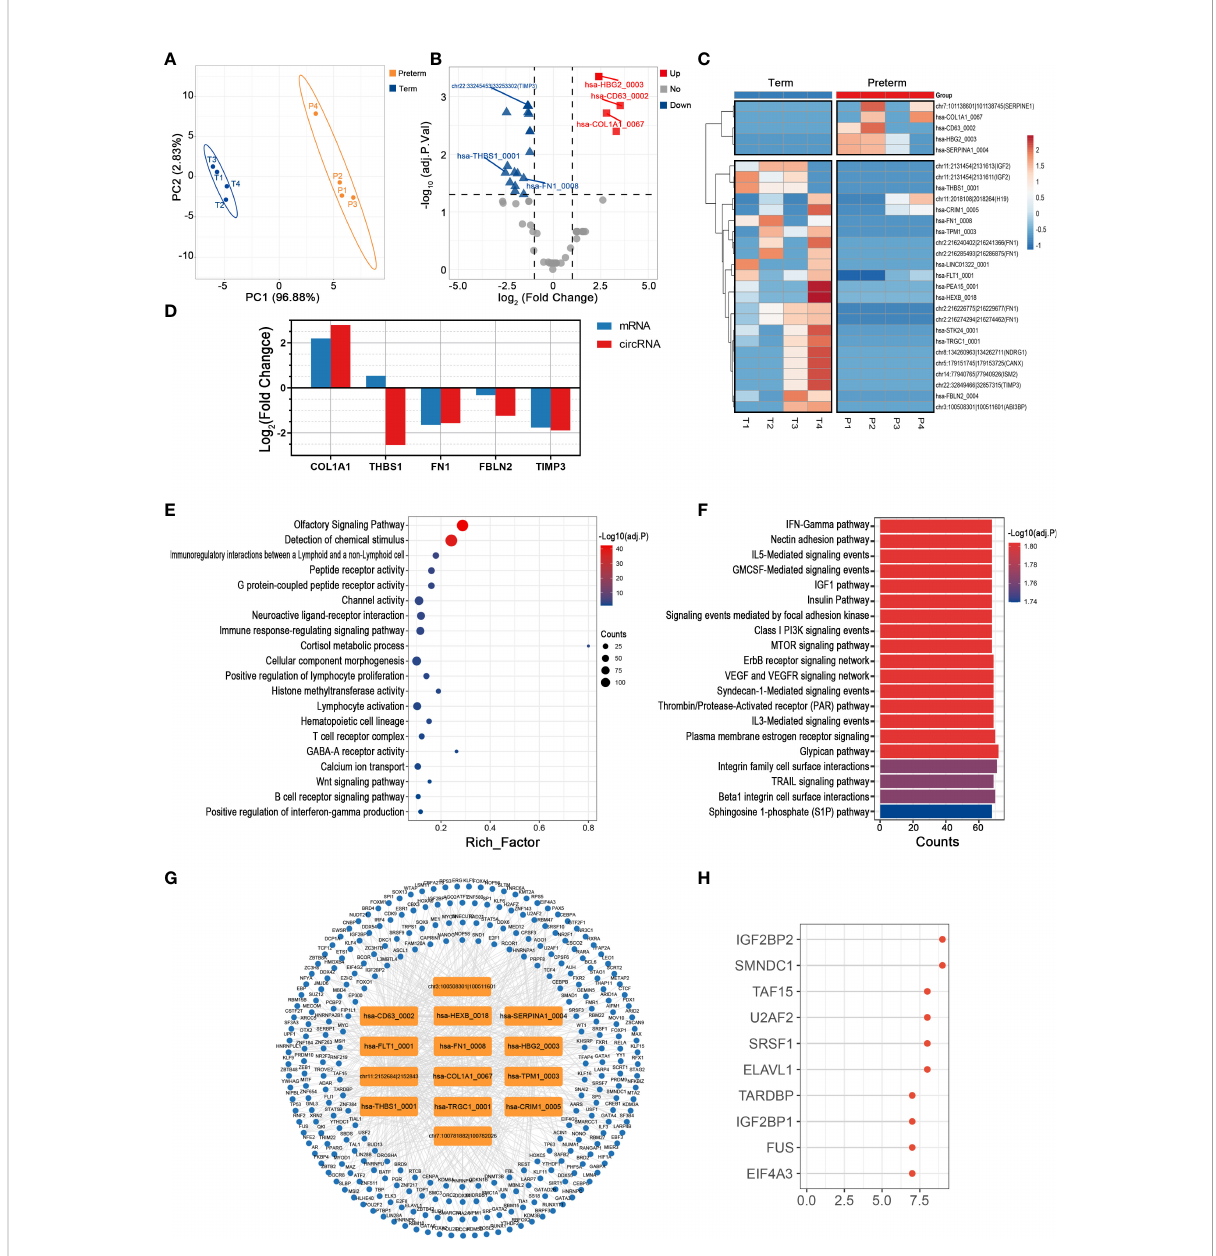
FIGURE 5 The circRNA changes and functional analyses in the chorion of PTB. (A) PLS-DA of circRNAs expression in preterm (yellow points) and term (blue points) chorion. (B) The volcano plot of circRNA changes and adj. p-values in the chorion of PTB. (C) The hierarchical clustering of DECs expression in term and preterm myometrium. (DECs: |log2 (fold change)|> 1 and adj. p-value < 0.05). (D) The fold changes of several speci fi c DECs and their corresponding mRNAs in the preterm compared to the term group. (E, F) Functional enrichment analysis of co-expressed mRNAs (E) and target miRNAs (F) of DECs in the preterm chorion. (G, H) The DECs-RBPs network and top 10 RBPs in the